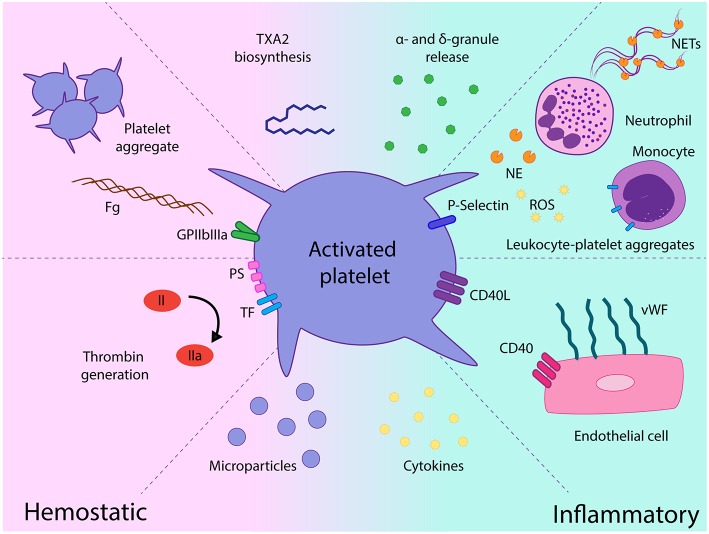
Role of platelets as mediators of hemostatic and proinflammatory responses in chronic myeloproliferative neoplasms (MPN). Platelet activation leads to increased GPIIbIIIa activation and platelet aggregate formation, platelet procoagulant response promotes thrombin generation on the platelet surface and platelet-derived microparticles futher fuel coagulation. Release of a miriad of α- and dense granule hemostatic and inflammatory mediators may contribute to the prothrombotic and proinflammatory loop. Enhanced interaction with leukocytes mediated by P-selectin leads to leukocyte-platelet heterotypic aggregates and may trigger several leukocyte responses, such as release of proteases, production of reactive oxygen species, and expression of tissue factor. Exposure of CD40L favors platelet recruitment and adhesion to the endothelium which, in turn, elicits endothelial cell activation, featured by vWF release from Weibel-Palade bodies. Elevated cytokines in the MPN milieu may promote platelet activation and, reciprocally, platelets may represent a potential source of inflammatory cytokines and chemokines. TXA2, thromboxane A2; Fg, fibrinogen; TF, tissue factor, PS phosphatidylserine; NE, neutrophil elastase; ROS, reactive oxygen species; NETs, neutrophil extracellular traps; vWF, von Willebrand factor, EC, endothelial cell.